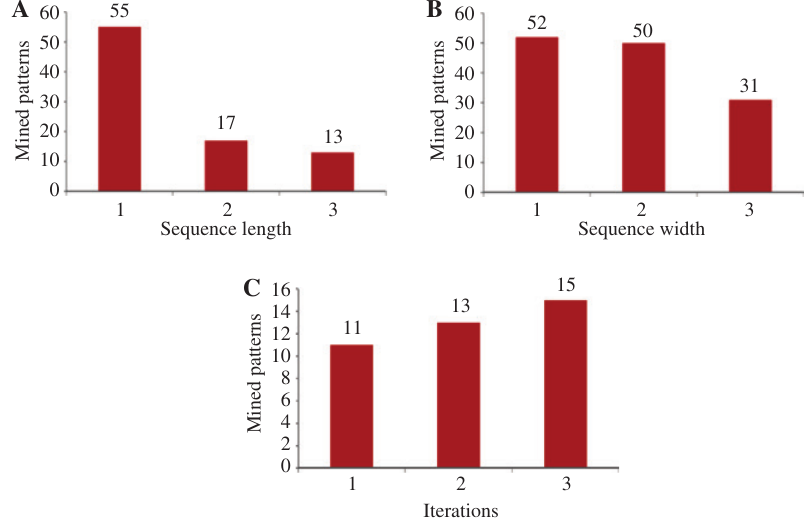
Figure 3: Number of Patterns Mined from Dataset 2.